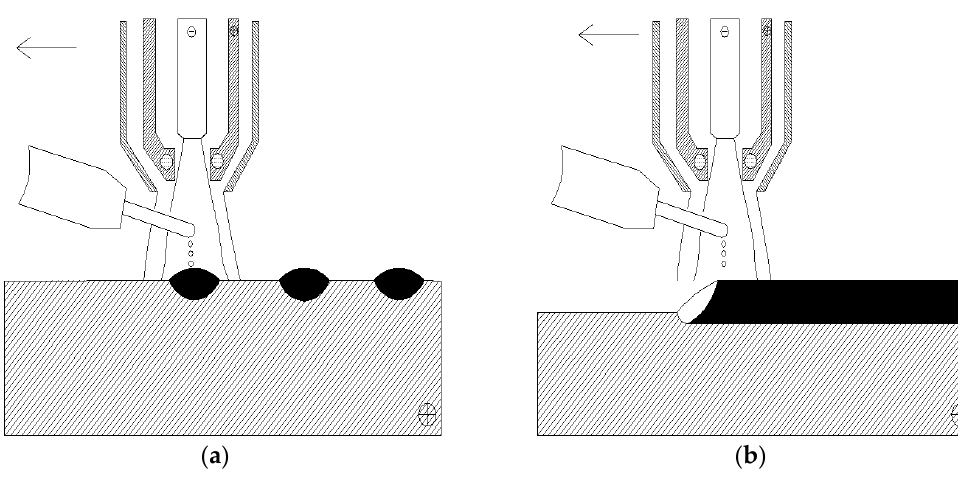
Figure 3. PTA cladding process: ( a ) The dot-shaped cladding (discrete dots); ( b ) The over-lapped cladding (continuous deposition).